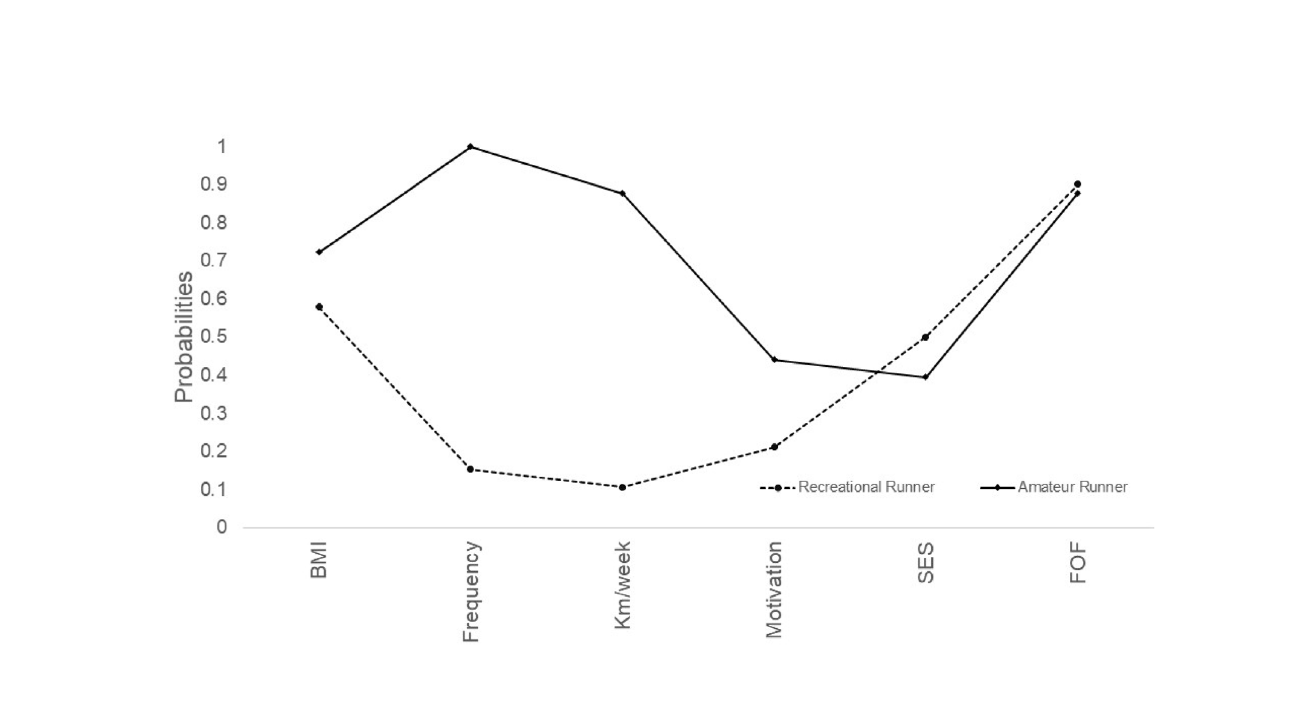
Figure 1 - Profiles for the 2-class latent class analysis model of Brazilian runners’